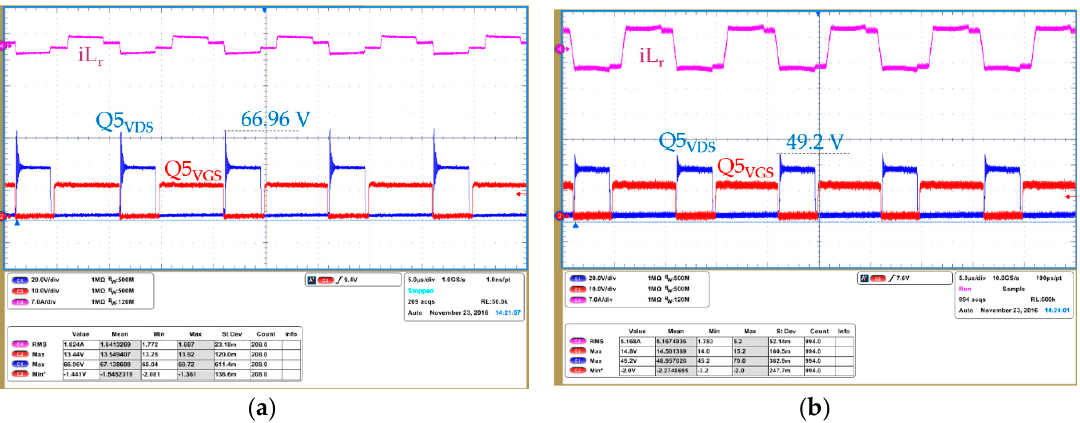
Figure 25. SRs drain voltage overshoot: ( a ) Working at 140 W of output power (10% of load); ( b ) working at 1400 W of output power (full load).